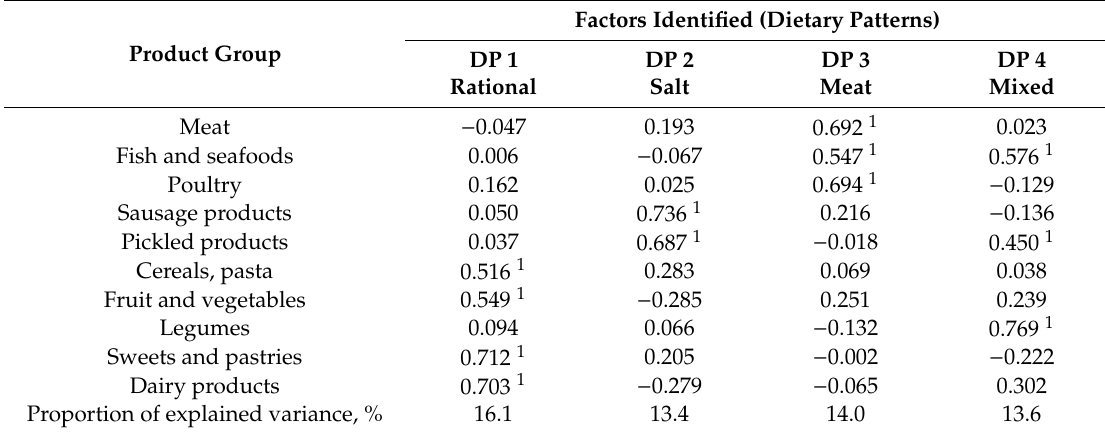
Table A3. Factor loadings of the principal dietary patterns identified (25–34